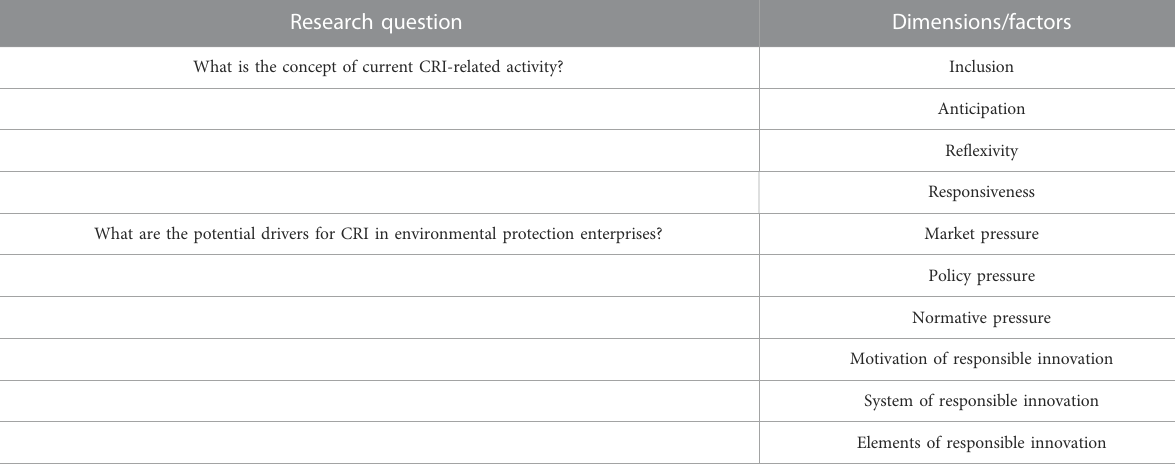
TABLE 3 Research questions and associated